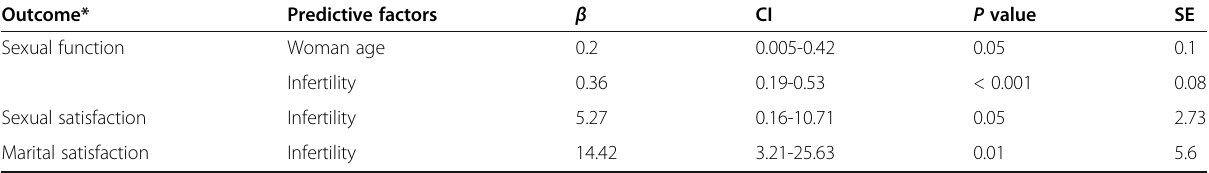
SE standard error, CI confidence interval * P values ≤ 0.05 were considered as significant